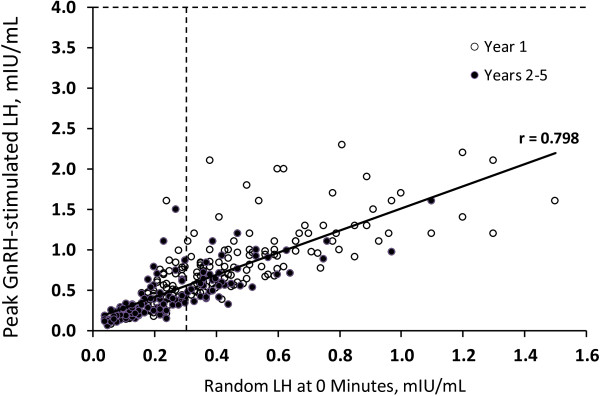
Scattergram of unstimulated versus peak GnRHa-stimulated LH levels during the histrelin implant therapy. Data from all follow-up visits (n = 308) during the first year of histrelin implant therapy (open circles) and the second through fifth year of therapy (solid circles) are shown. The horizontal dashed line represents the a priori peak GnRHa-stimulated LH threshold level of 4 mIU/mL defining adequate suppression. The vertical dashed line indicates the published 0.3 mIU/mL pubertal threshold for unstimulated LH levels [15].